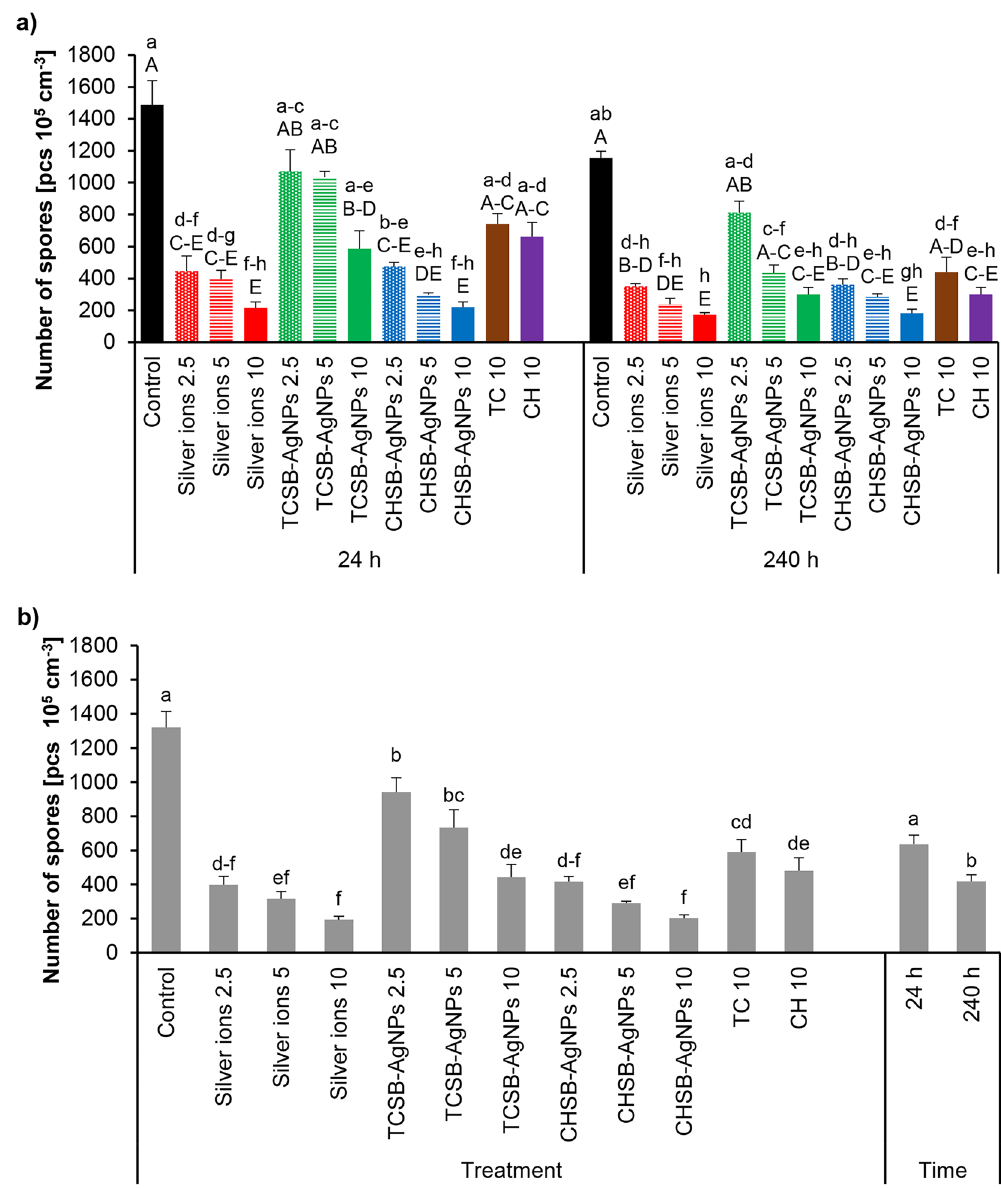
Figure 5. The impact of silver ions, AgNPs and stabilizing agents on the sporulation of F. avenaceum after culture over 24 h and 240 h of the exposure period: factors interaction effect ( a ), factors effect ( b ). Data represents mean values ± SE. Values marked with the same letters (lowercase letters for the interaction effect, as well as the main effects of time and treatment; capital letters for interaction effect separately for the hours) are not significantly different at p ≤ 0.05. The number given for each treatment represents the concentration expressed in mg L −1